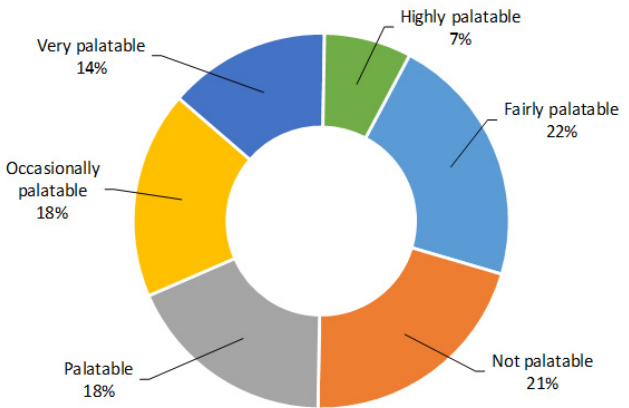
Figure 6. Palatability of plant species in the arid and desert rangelands of Tataouine, Tunisia (spring 2018).